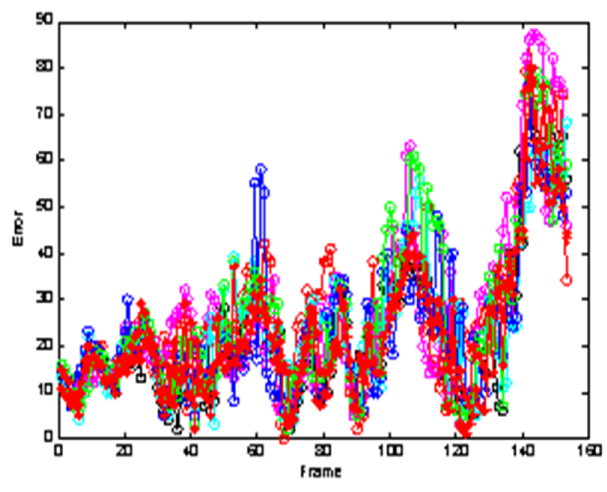
Figure 4. The analysis robustness.